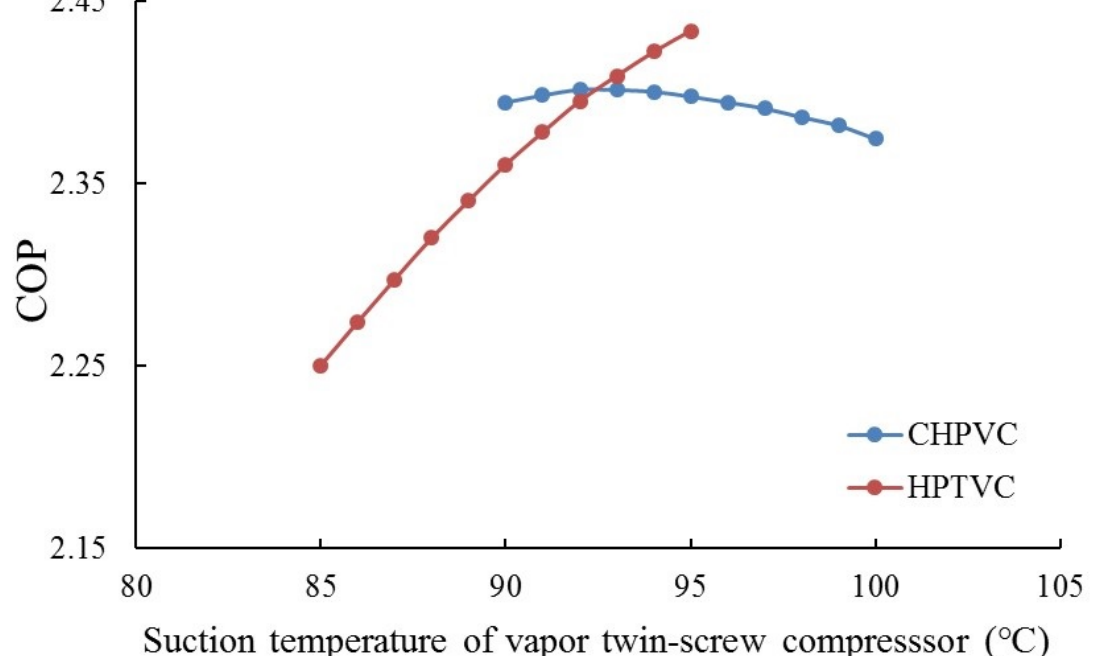
Figure 6. COP versus the suction temperature of the vapor twin-screw compressor.